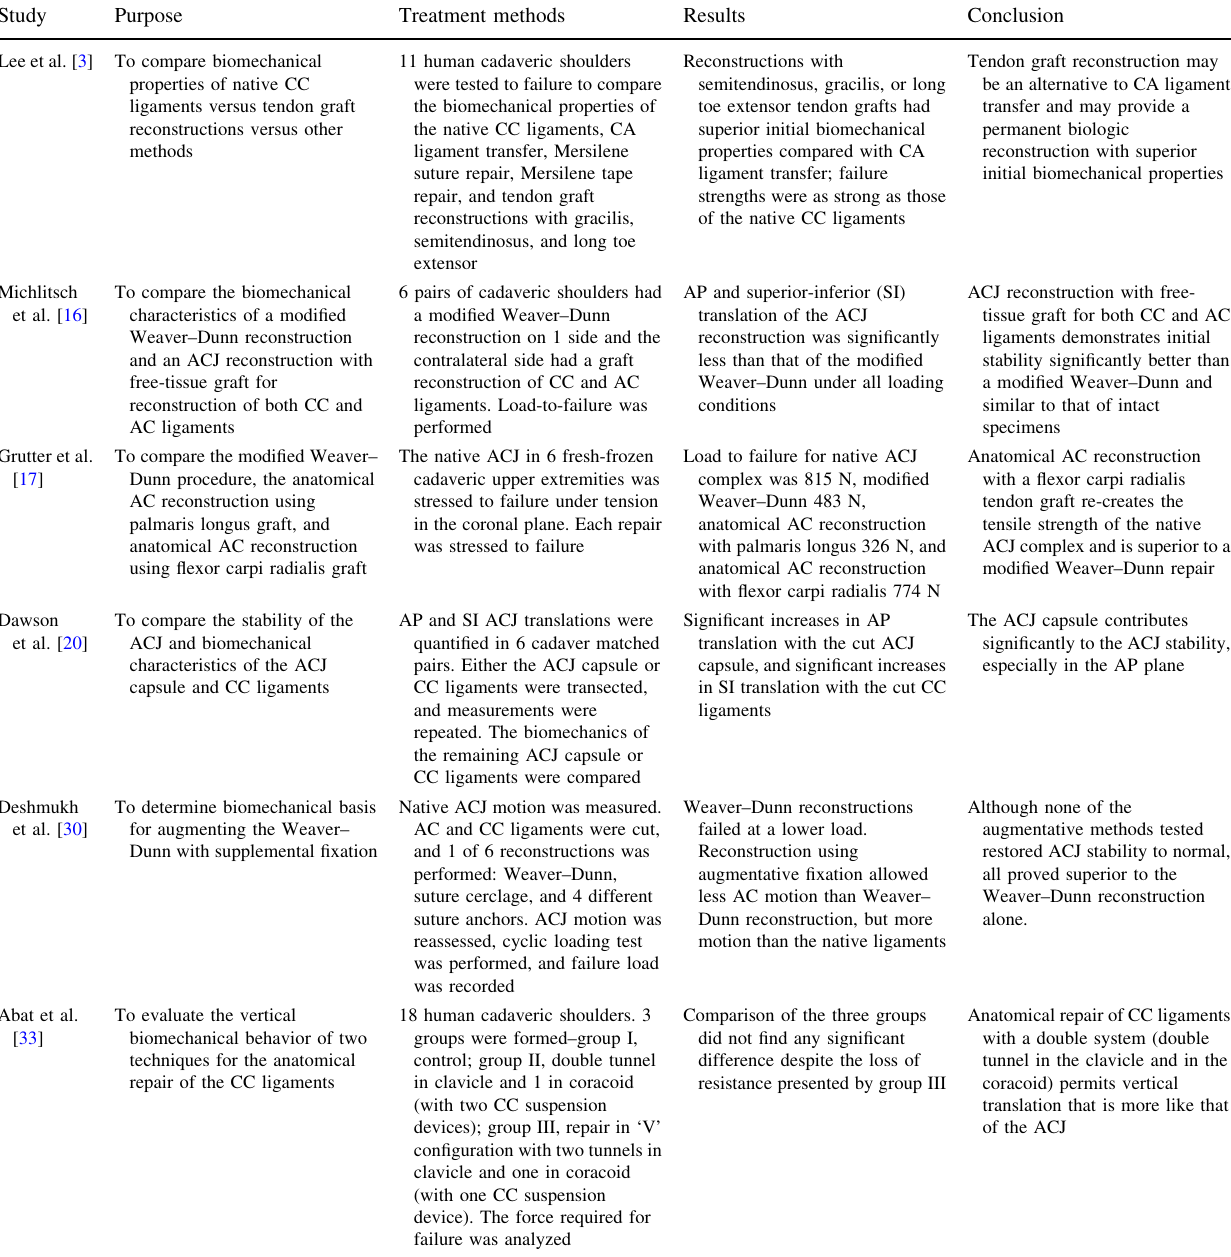
Table 2 Summary of the main aspects of the cited biomechanical